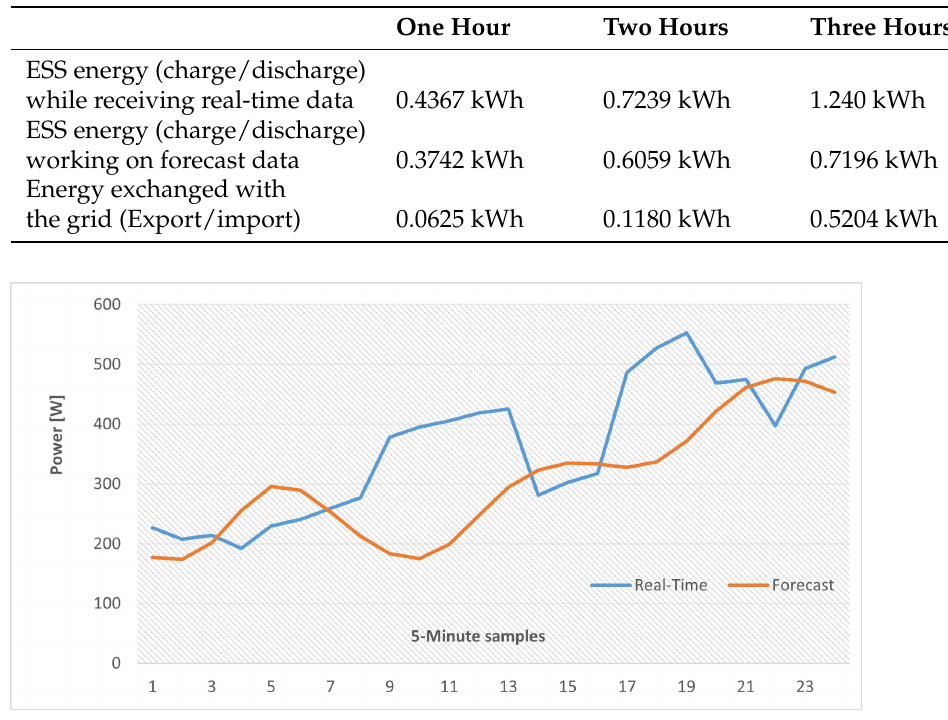
Figure 14. Internal power excess/deficit inside the MG (Two hour test).